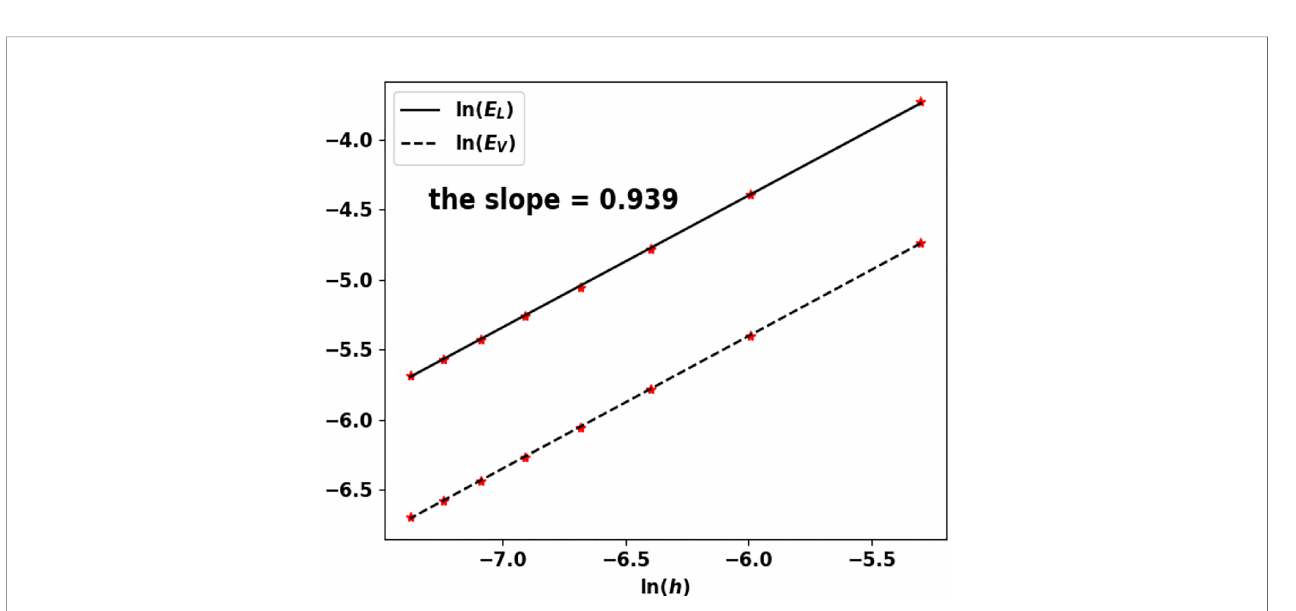
FIGURE 13 | Uniform fragmentation, ex. 2: rate of convergence to the exact eigenpair with respect to h